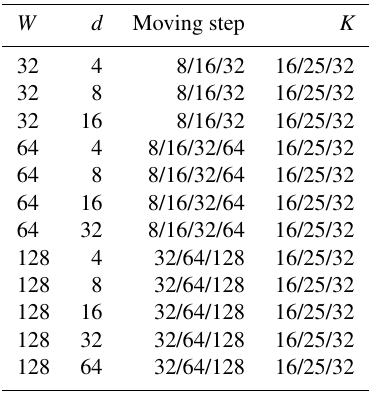
Table 1. Experiments of computation parameters. W is the window size, d is the co-occurrence distance, K is the quantized gray level, and moving step is a step of sliding window